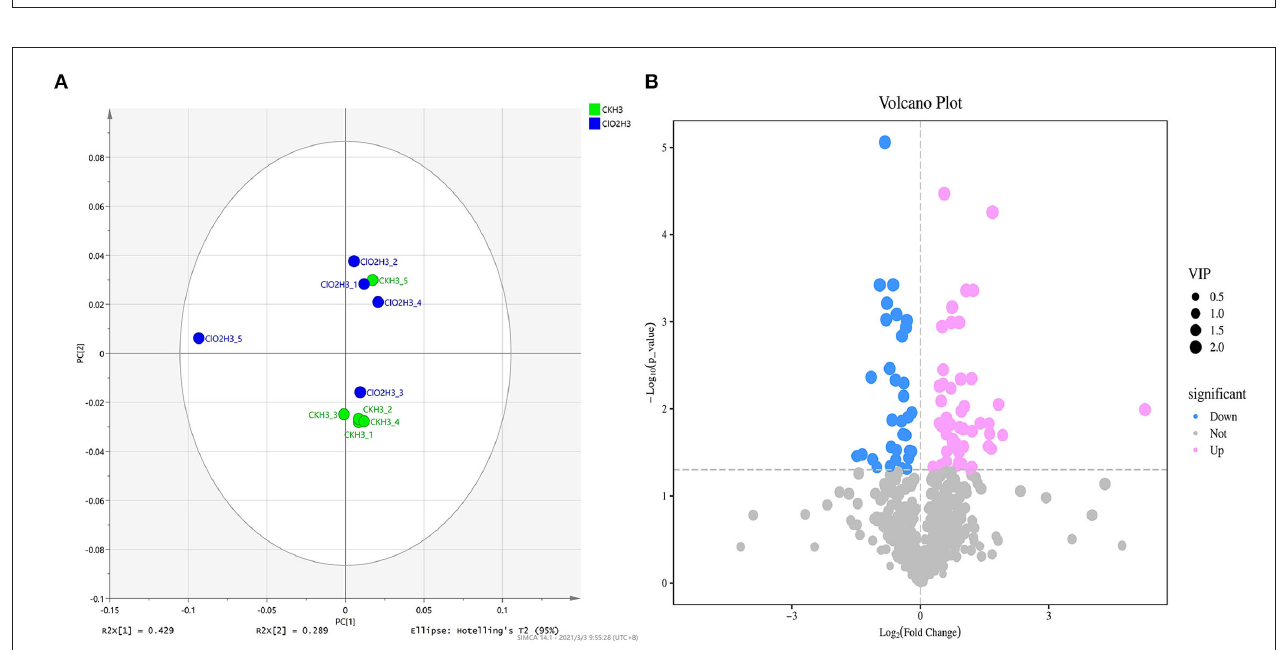
FIGURE 4 | (B) (AUXIAA, auxin-responsive protein IAA; ARF, auxin response factor;GH3, auxin-responsive GH3 gene family; SAUR, SAUR family protein; CRE1, cytokinin receptor; AHP, histidine-containing phosphotransfer protein; A-ARR, two-component response regulator ARR-A family; TF, phytochrome-interacting factor 4; PYR/PYL, abscisic acid receptor PYR/PYL family; PP2C, protein phosphatase 2C; SnRK2, serine/threonine-protein kinase SRK2; ABF, ABA-responsive element binding factor; ETR, ethylene receptor; JAR1, jasmonic acid-amino synthetase; JAZ, jasmonate ZIM domain-containing protein; TGA, transcription factor TGA; PR-1, pathogenesis-related protein 1).